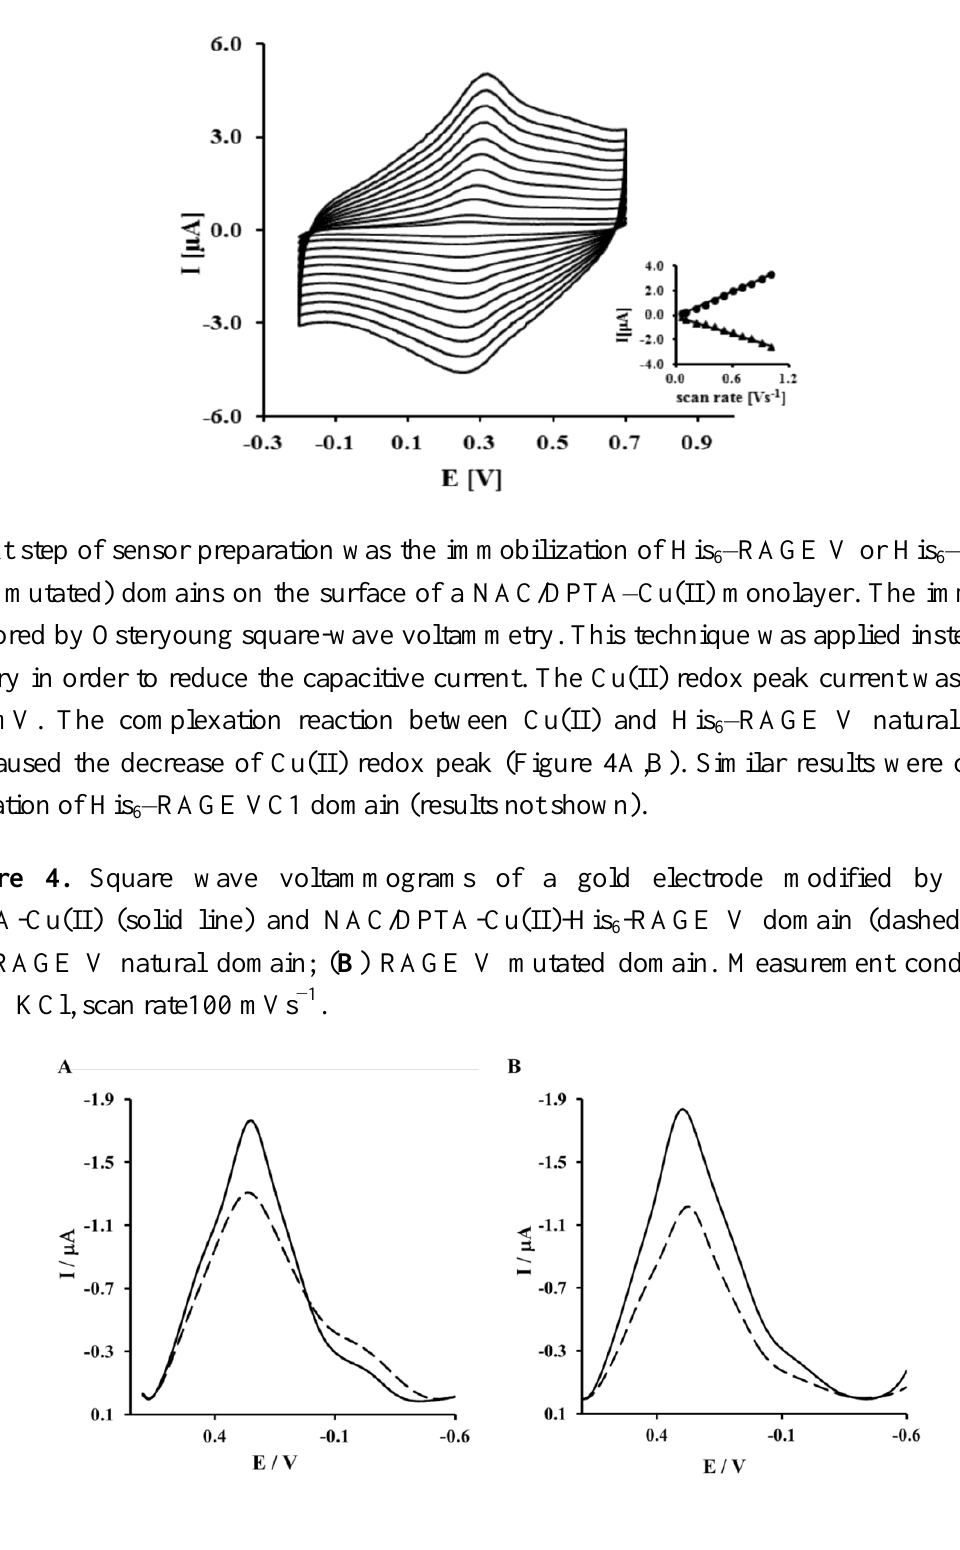
Figure 3. CV curves for gold electrodes modified by NAC/DPTA–Cu(II) SAM measured in 0.1M KCl. Scan rates: 50–1,000 mVs −1 .